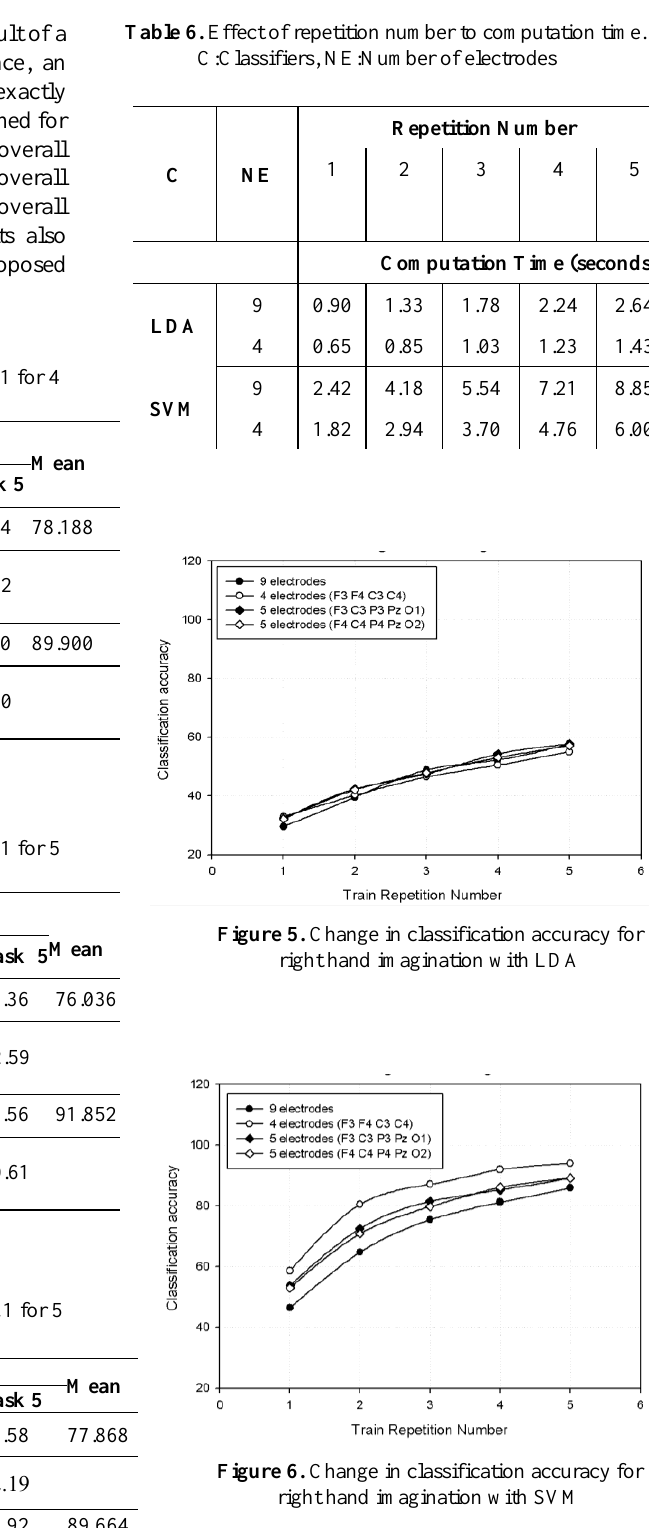
Table 6. Effect of repetition number to computation time.